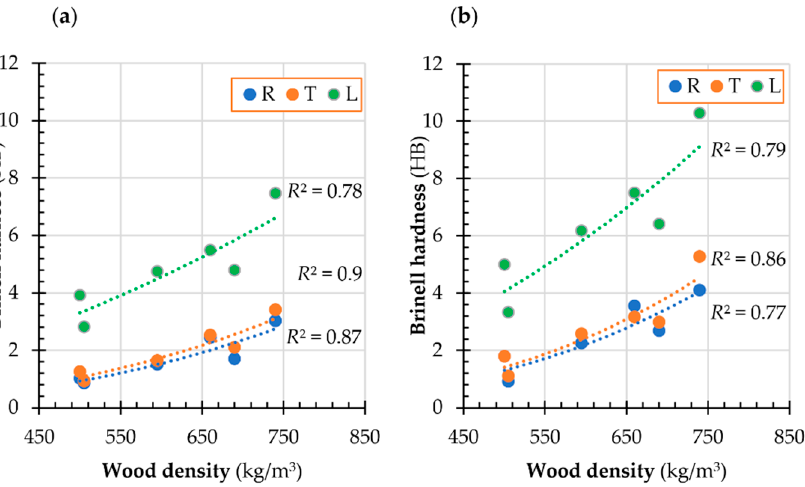
Figure 6. The Brinell hardness—wood density: ( a )—30 kG measuring force, ( b )—100 kG measuring force.